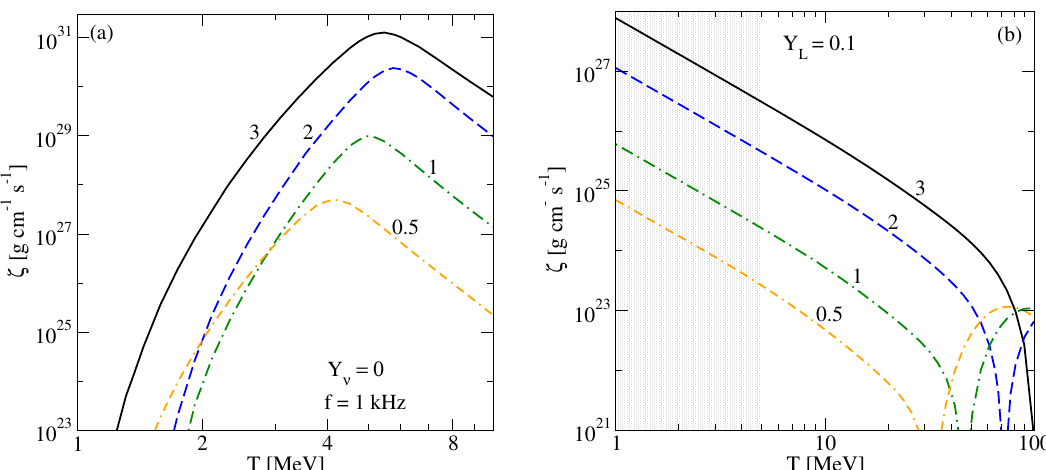
Figure 5. The temperature dependence of the bulk viscosity for several values of the baryon density marked on the plots for ( a ) neutrino-transparent matter; ( b ) neutrino-trapped matter at Y L = 0.1. The oscillation frequency is f = 1 kHz in panel ( a ); the bulk viscosity in panel ( b ) is frequency independent. Note the very different y -axis scales. The shaded region in panel ( b ) indicates that the results therein are extrapolations to the regime where they are not applicable.